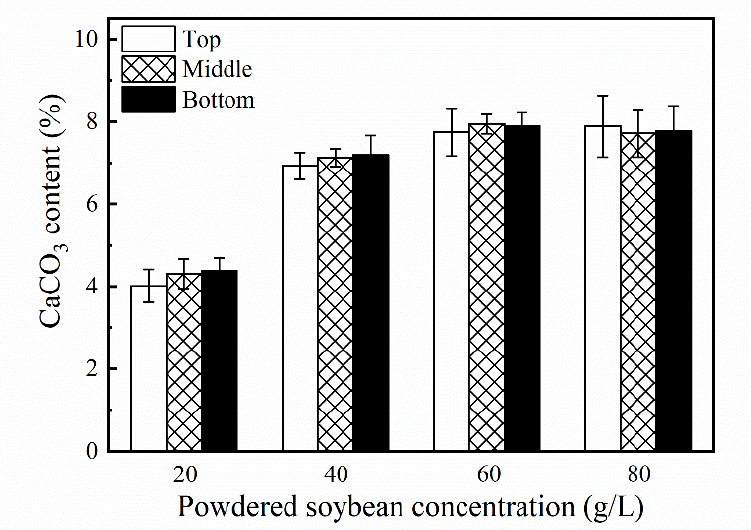
Figure 12. Calcium carbonate content distribution in EICP-treated sand samples after eight treat- ments.